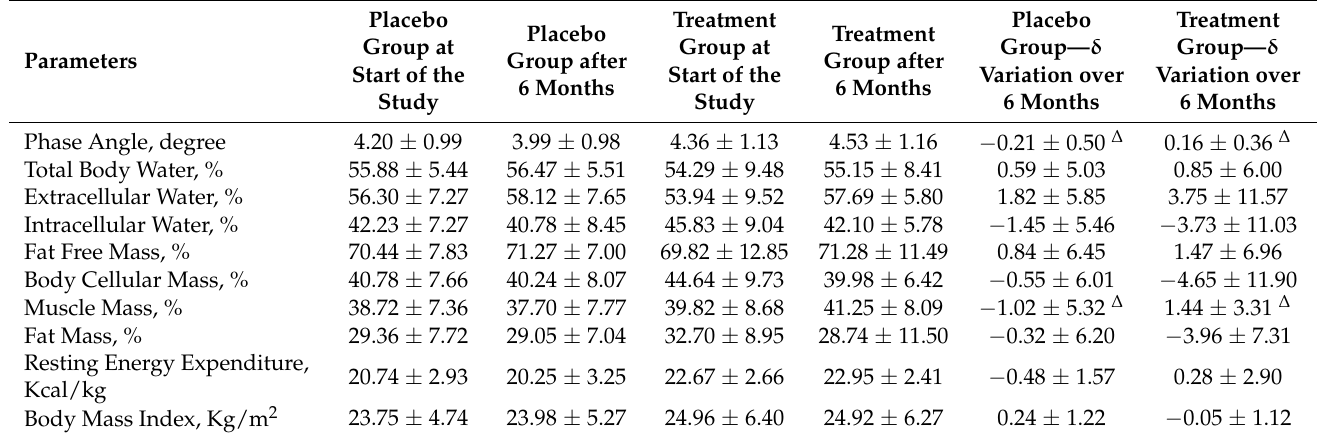
Table 3. Difference in Bioimpedance Analysis between Treatment and Placebo Groups and Differences observed in Temporal Inter-Study ( δ ) and Intra-Study Group